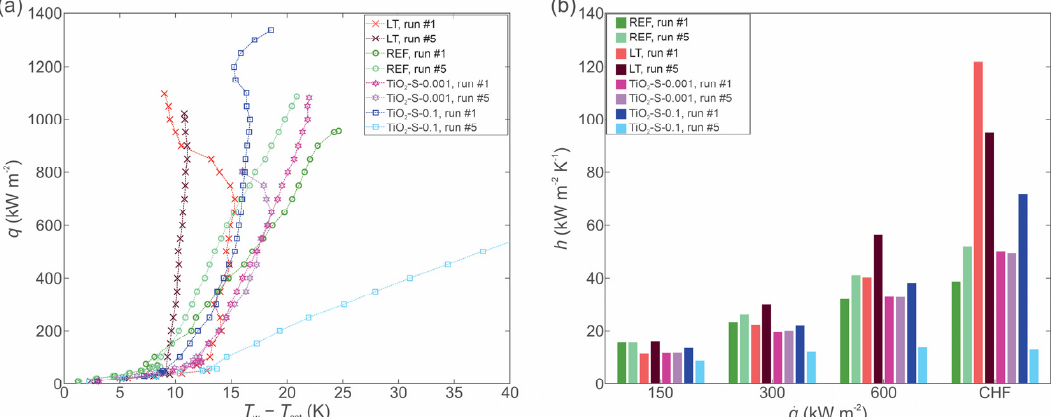
Figure 13. Comparison of boiling characteristics of TiO 2 -water nanofluids with small size nanopar- ticles with the performance of pure water on reference and LT surface (1st and 5th run): boiling curves ( a ) and heat transfer coefficients ( b ) .